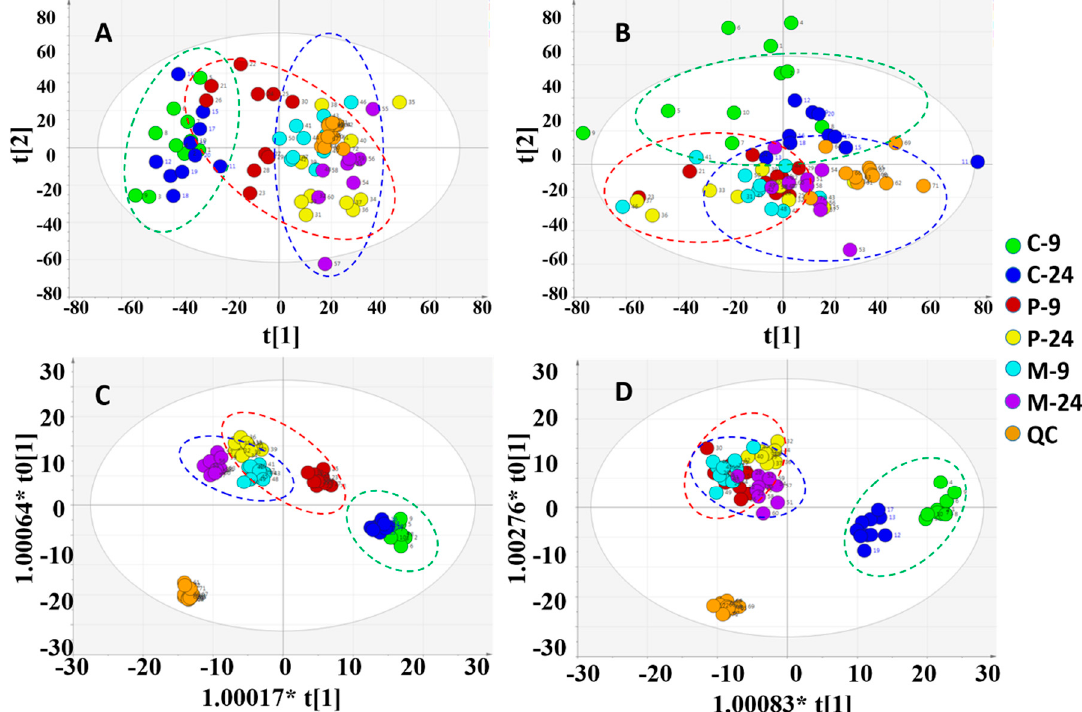
Figure 3. Overview of the rat serum samples: ( A ) PCA score plot in positive ion mode; ( B ) PCA score plot in negative ion mode; ( C ) OPLS-DA score plot in positive ion mode; ( D ) OPLS-DA score plot in negative ion mode (C-9: control group at 9 h;C-24: control group at 24 h; P-9: P-b4 group at 9 h; P-24: P-b4 group at 24 h; M-9: model group at 9 h; M-24:model group at 24 h; QC: quality control samples).